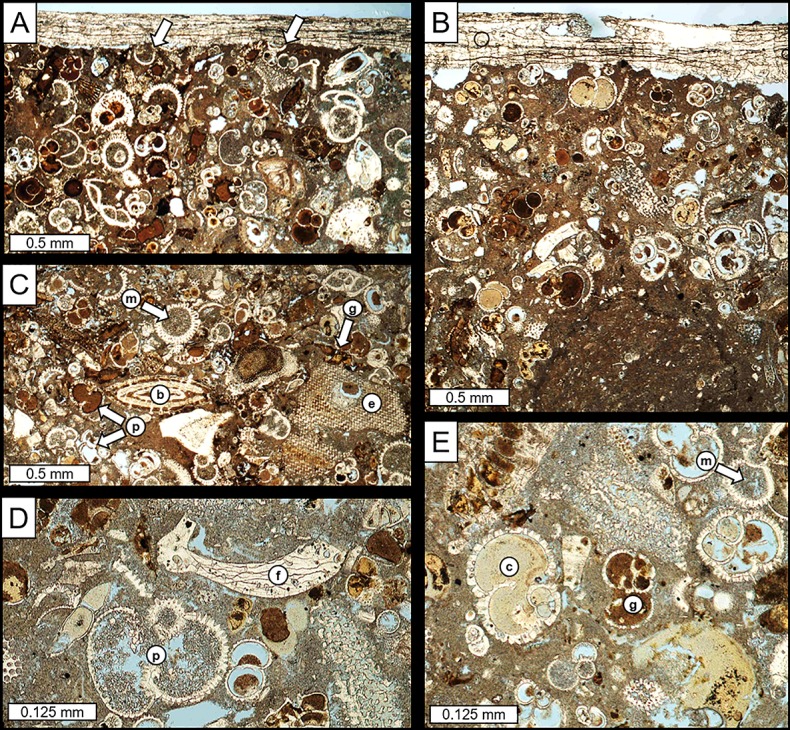
Photomicrographs of limestone substrate.(A, B) packed biomicrite and associated L. abatanica tube linings (top of each photo). Arrows in A highlight thin-shelled foram tests that have been truncated at the boring wall. Darker pod of sparse biomicrite in lower part of B is a burrow fill or intraclast. (C) Planktonic (p) and benthonic (b) forams and echinoderm fragments (e). Intraparticle pores are filled with micrite (m) and brown Fe-rich cement (goethite?; g). (D) Planktonic foram (p) and microbored bivalve fragment (f). (E) Open intraparticle pores (blue) and intraparticle pore-filling cements, including micrite (m), goethite? (g), and chamosite? (c).